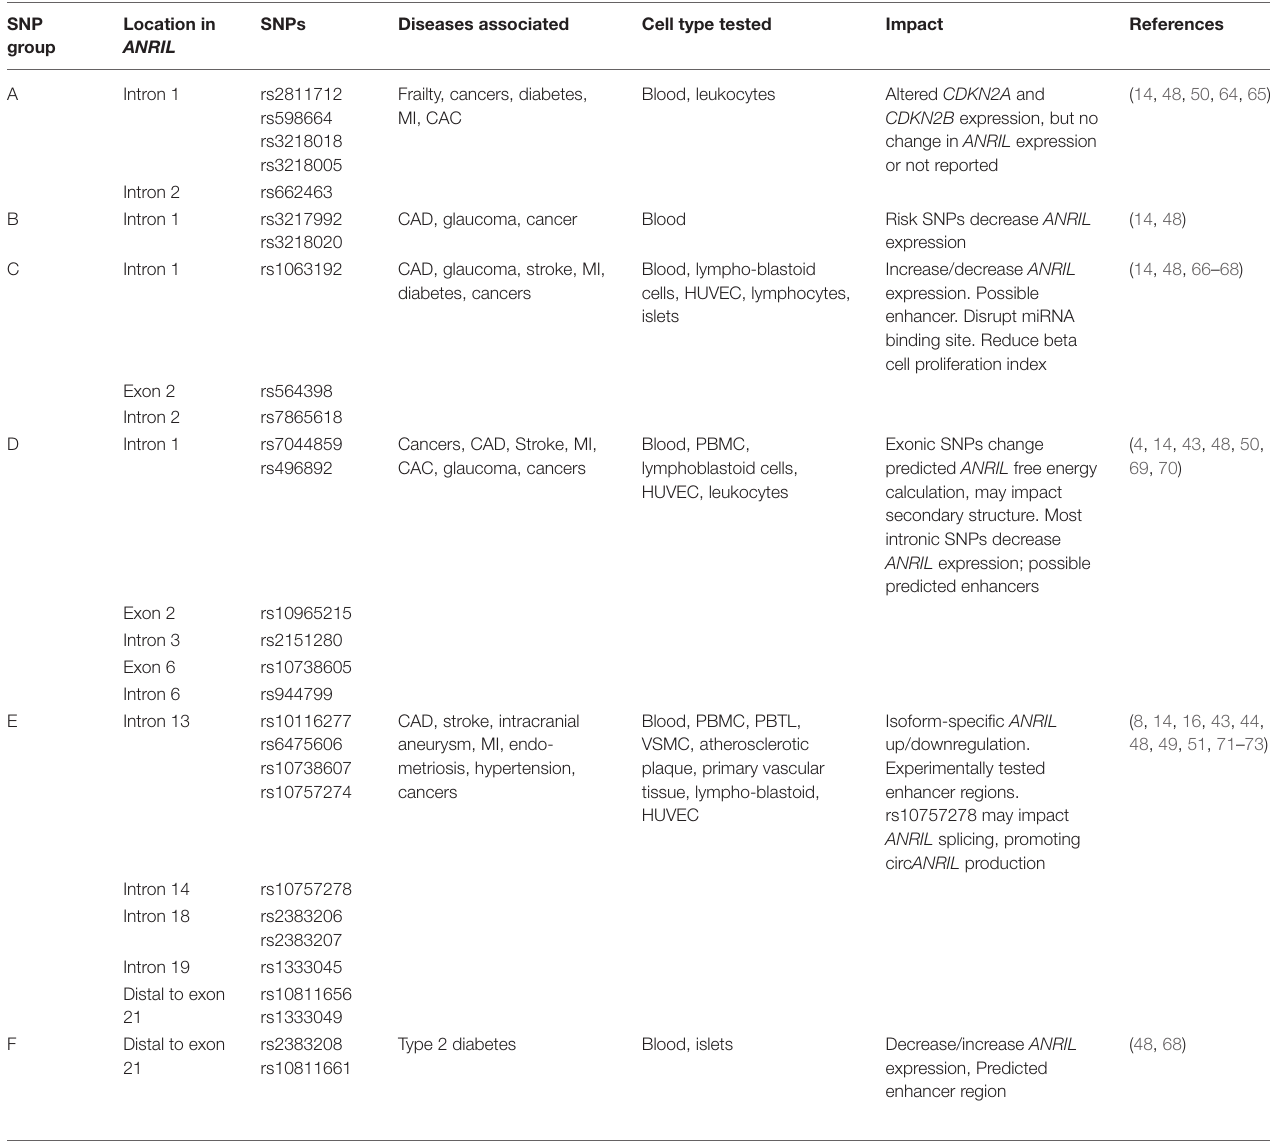
TABLE 1 | Disease associated SNPs in/near the ANRIL gene that modulate locus gene expression. SNP